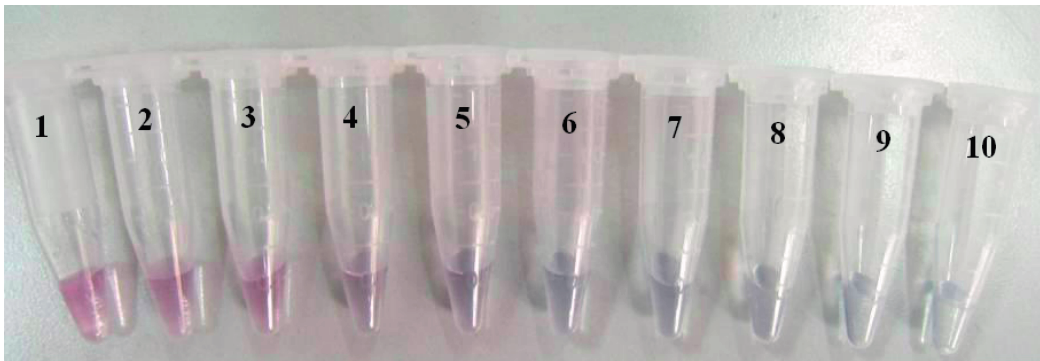
Figure 4. Optimal amount of marker protein for the